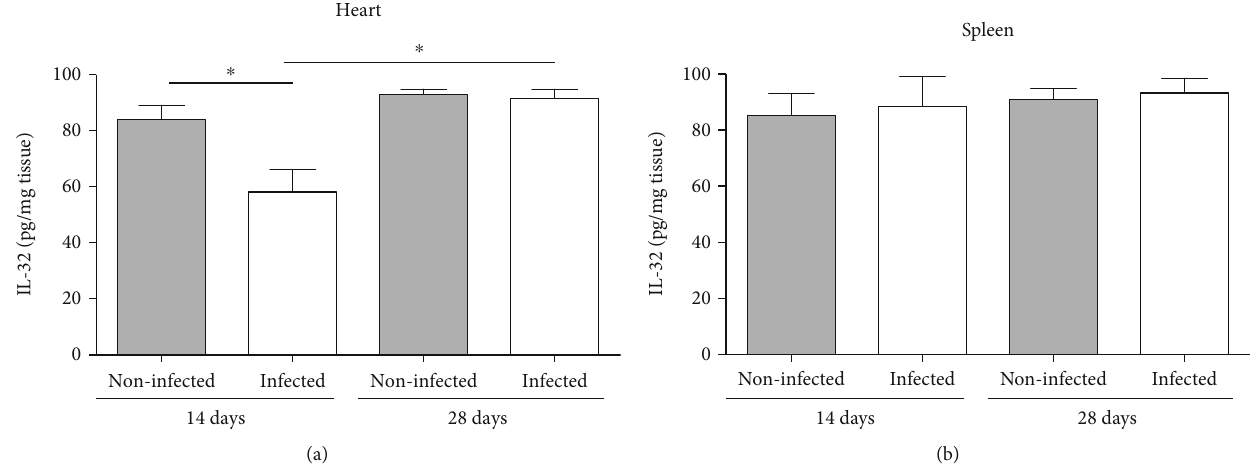
Figure 4: Levels of IL-32 in the (a) heart and (b) spleen of noninfected or infected IL-32 γ Tg mice. Mice were infected with Colombian strain of T. cruzi , and IL-32 was measured in heart tissue during the acute phase of experimental Chagas disease. ∗ p < 0 : 05 (two-way ANOVA test with Bonferroni post hoc